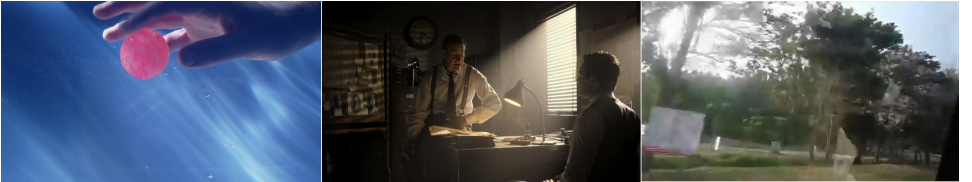
Figure 5. Example images from the following three databases under test: ( left ) BVI-HD [22]; ( center ) NFLX-II [5]; and ( right ) YouTube UGC [24]. The BVI-HD and NFLX-II databases have originals of high-quality, stable videos. The huge YouTube UGC dataset has mostly modest quality, user- generated videos, but with its wide variety, it even has 4K HDR